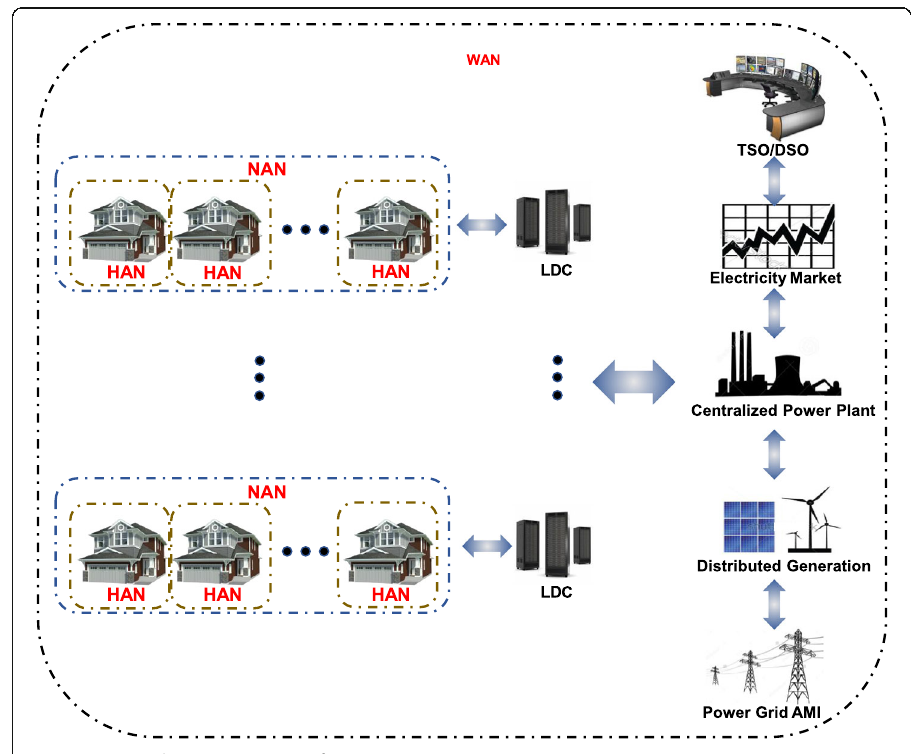
Fig. 2 Smart grid communication